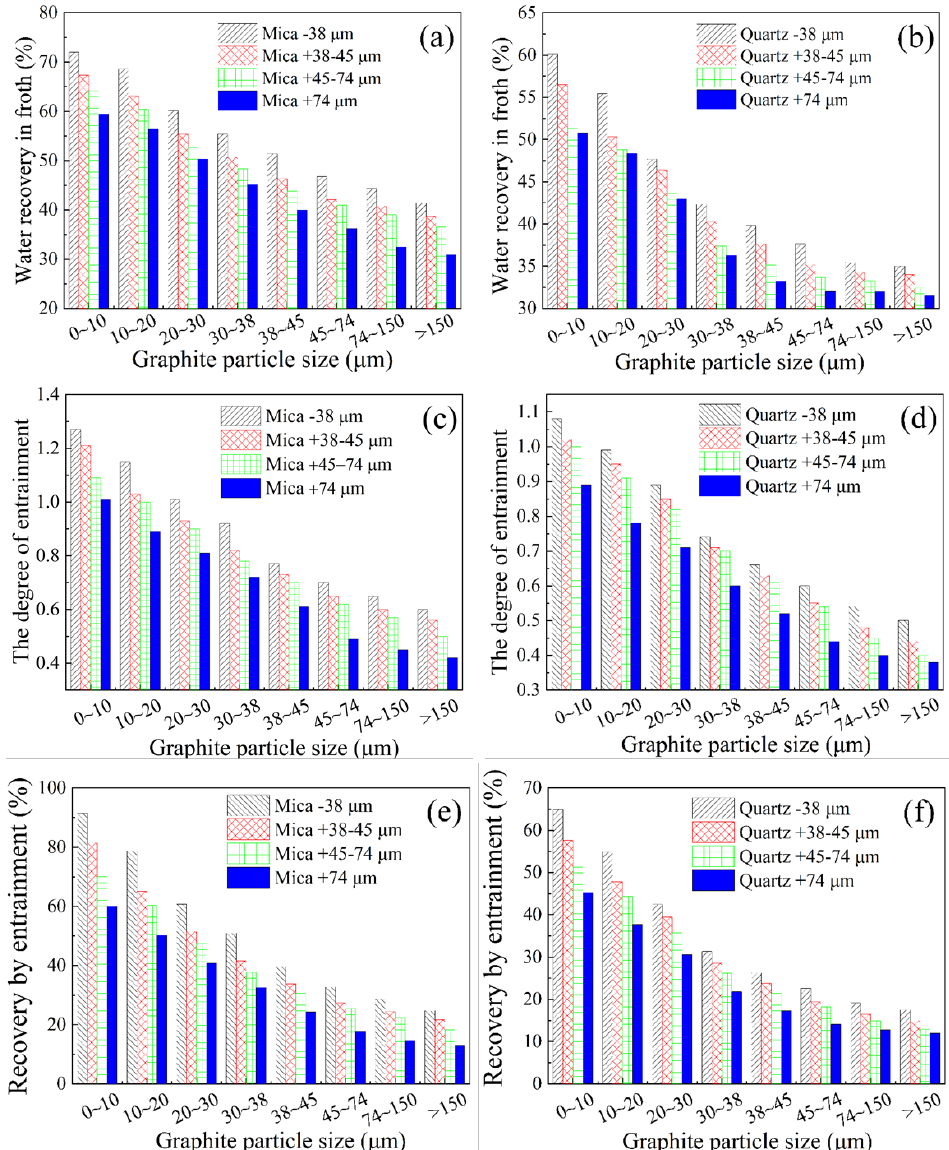
Figure 11. The effect of graphite particle size on the entrainment of gangue minerals in mixed flota- tion: ( a ) the water recovery in froth; ( b ) the degree of entrainment; and ( c ) the recovery of gangue by entrainment.